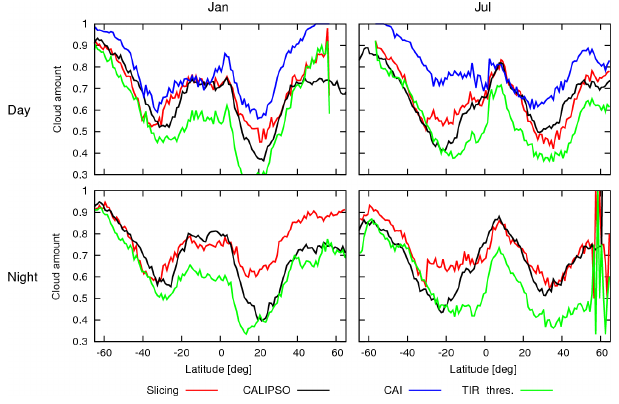
Figure 5. Latitudinal variations of monthly mean CA during day- time and nighttime in January and July from the slicing (red line), CALIPSO (black line), CAI (blue line), and the TIR threshold method (green line).